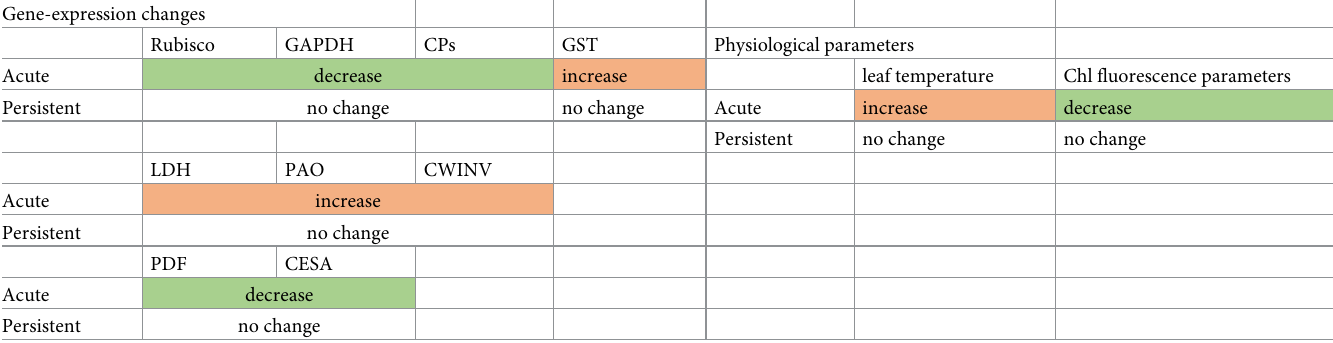
Table 1. Summary of basic differences between acute and persistent virus infections which could be used to predict type of the infection. Gene-expression